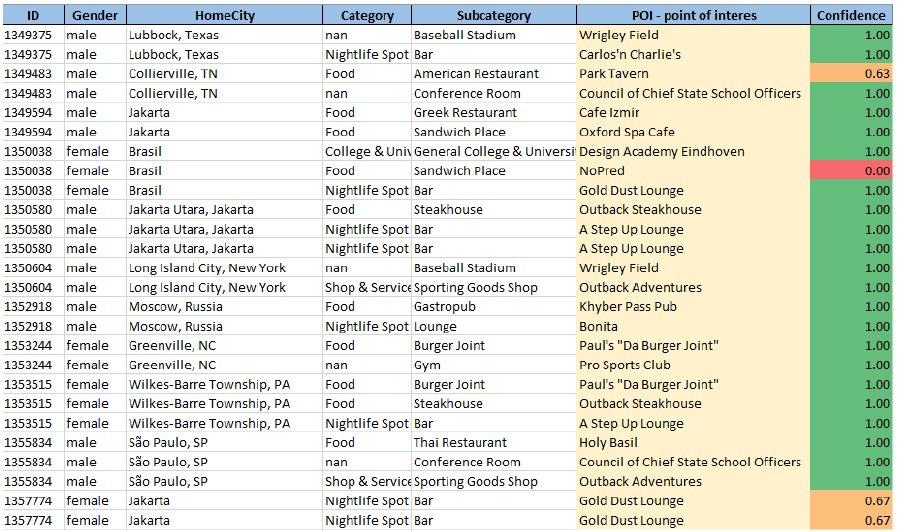
Figure 3. An excerpt of evaluation results regarding recommendation and confidence.